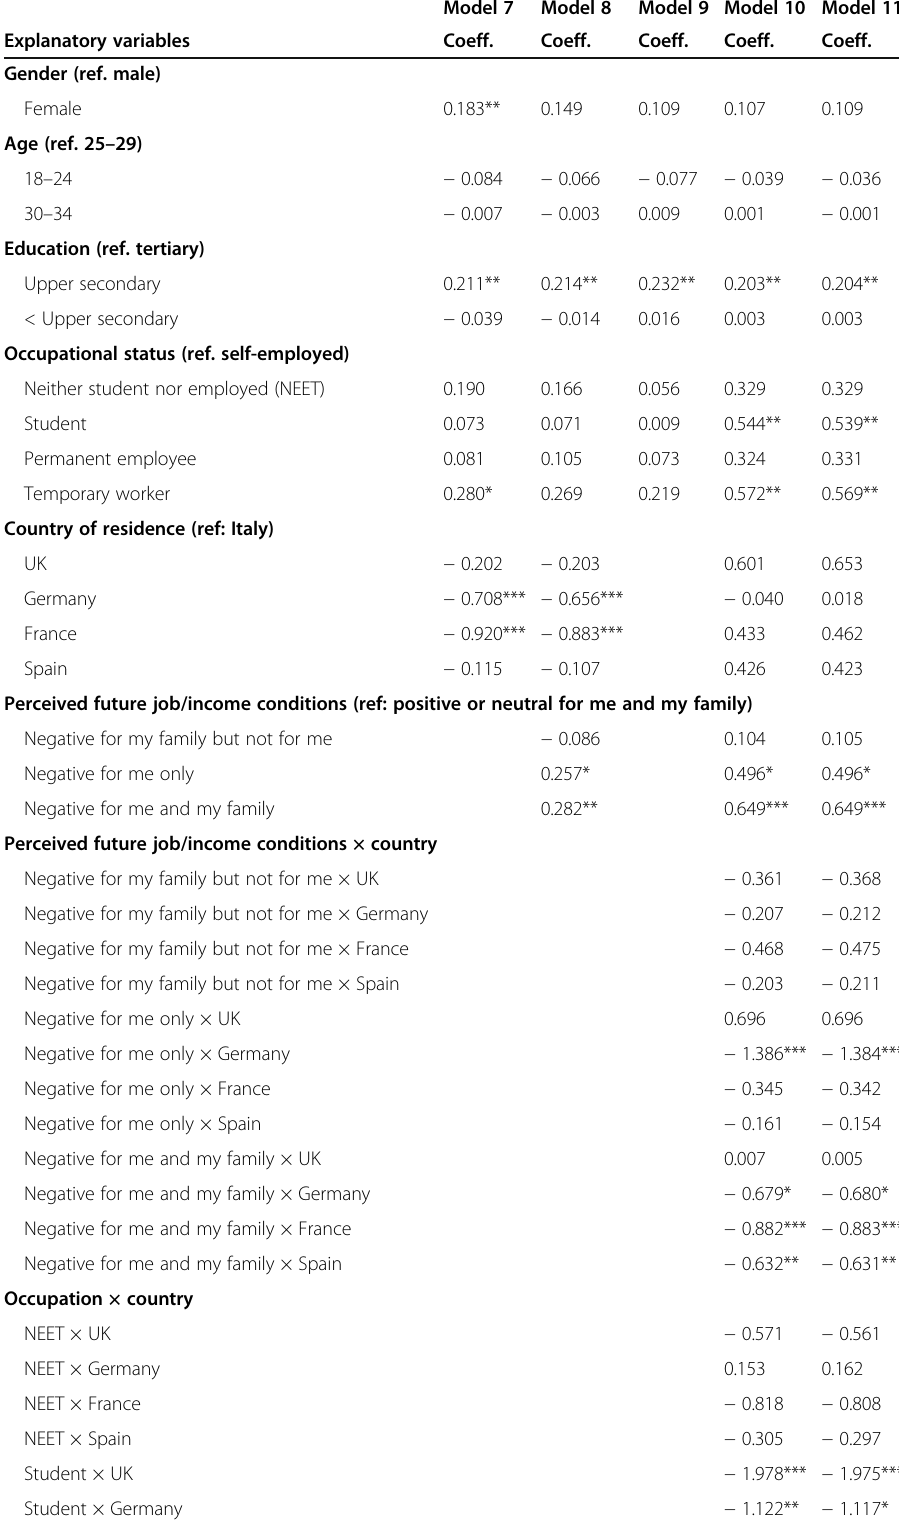
Table 6 Results of ordered logistic regression for the determinants of the decision of postponing or abandoning the plan of going to live on their